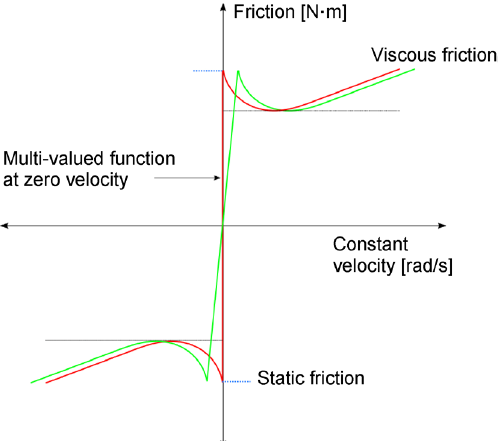
Fig. 6 The combined effect of Coulomb friction, viscous friction and low velocity Stribeck effect based on Ref.